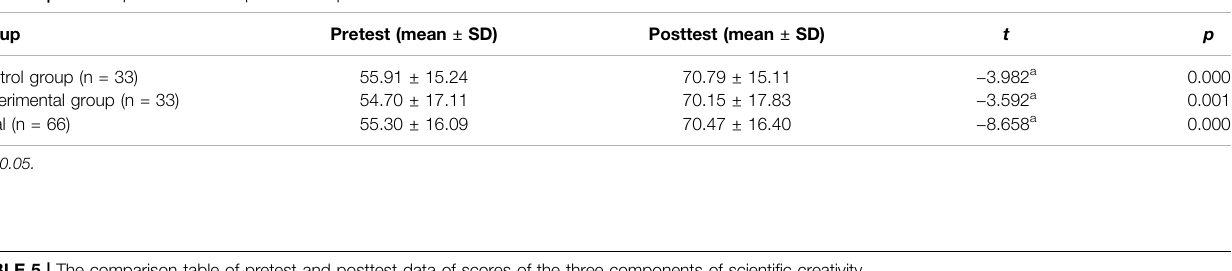
TABLE 5 | The comparison table of pretest and posttest data of scores of the three components of scienti fi c creativity. Components